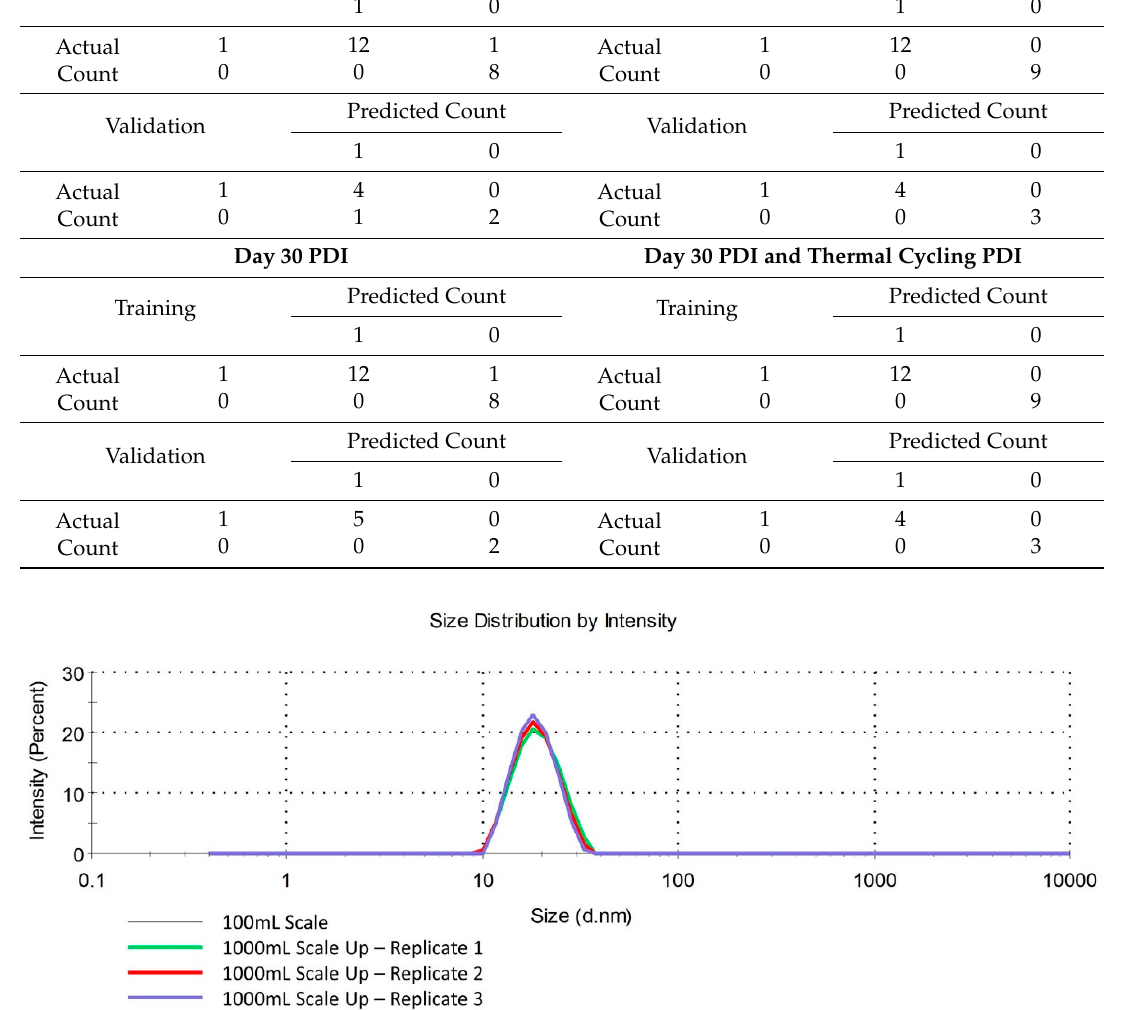
Figure 3. Size distribution by intensity of microemulsions produced on a 1L scale compared to that of a microemulsion produced on a 100mL scale. Scale up of the microemulsion to 1 L can be done consistently and does not impact microemulsion diameter or PDI, suggesting a robust formulation. Table 11. Summary of CQA specification testing for scaled up (1000 mL) microemulsions.